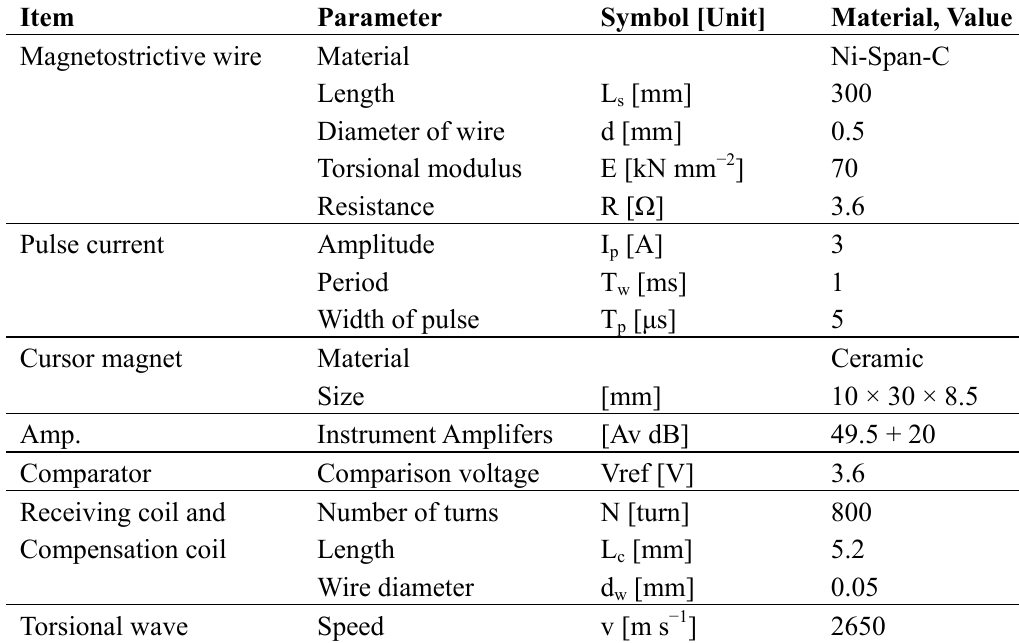
Table 1. Experimental conditions for the